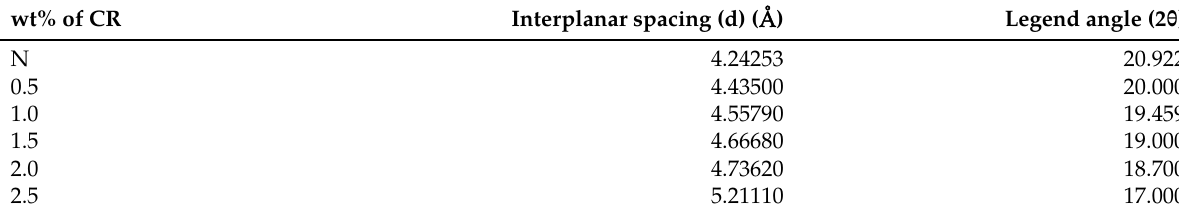
Table 14: Interplanar spacing and legend angle for different compositions of